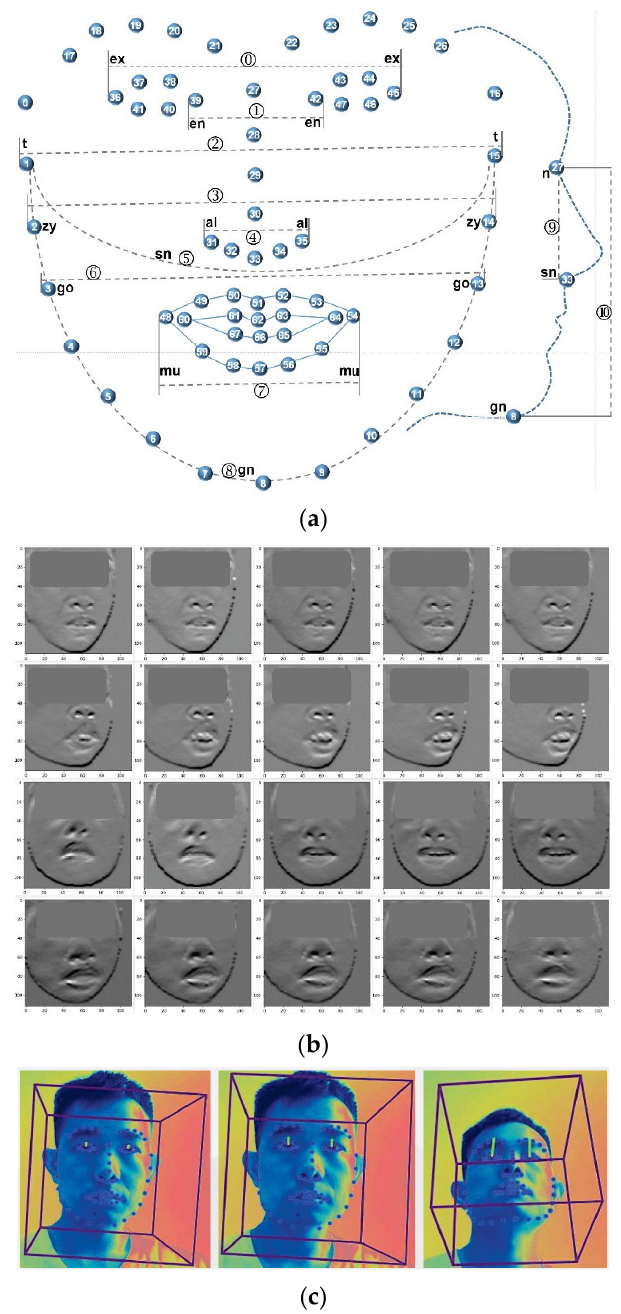
Figure 2. 3D facial feature extraction and facial phenotype definition. ( a ) The 11 Geometric Features referenced from CVI; ( b ) Face Detection; ( c ) 3D Feature Extraction